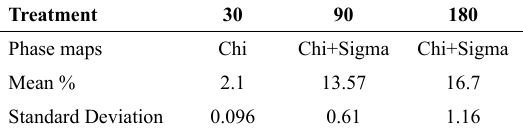
Table 3. Amount of chi and sigma phases for the different treatment conditions, as measured by the counting method from EDS mapping images, method image analysis.